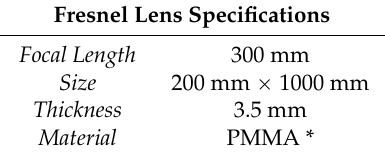
Table 1. Fresnel lens technical specifications from Microsharp.